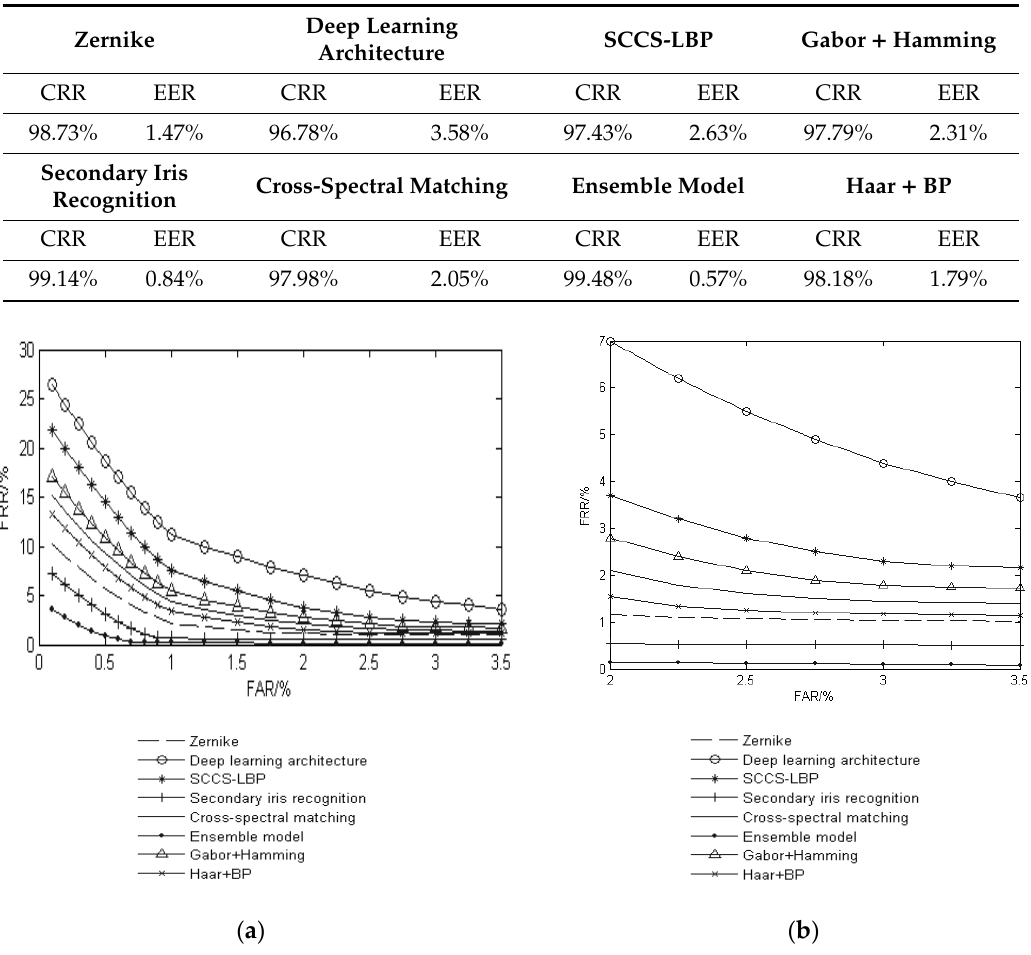
Figure 13. The ROC curve of JLU-6.0: ( a ) Global map; ( b ) Partial magnification.